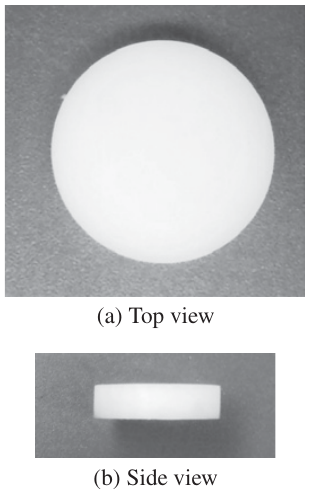
Fig. 11. Photograph of compressive test specimen after compres- sion (Experiment); 550 [1 / s] of Fig. 7.